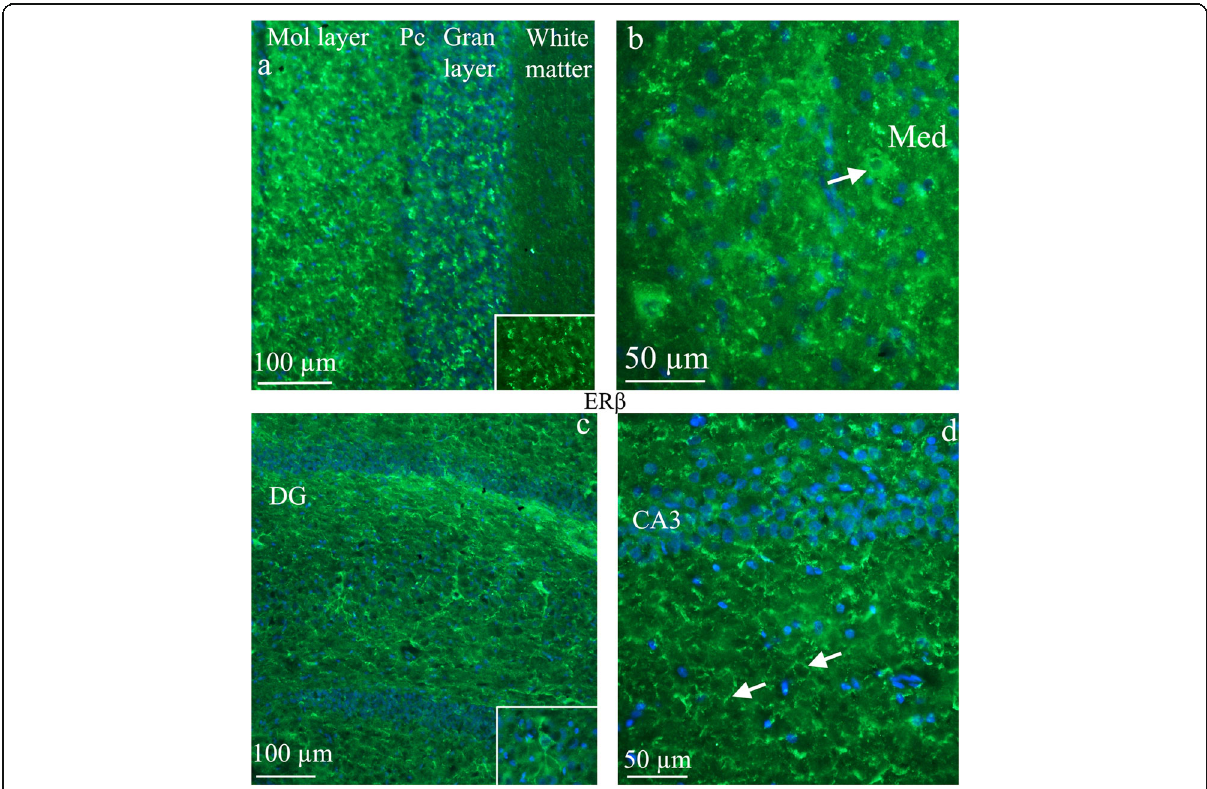
Fig. 3 ER β receptor distribution. a and b ) ER β receptor distribution in the cerebellum - the expression of ER β was often observed in tiny loop- formations or short curvatures in areas close to the cell surface or intercellularly, reminiscent of extra cellular matrix distribution. In the cerebellum, the typical ER β expression was found in the molecular (mol layer) and granular (gran layer) layers, but not in the Purkinje cells (Pc) and not in the white matter. Insert: staining of the granular layer. In Medial cerebellar nuclei (Med), occasional neuronal expression was observed (arrow). c and d ) ER β receptor distribution in the hippocampus - the dentate gyrus (DG) and CA3 are parts of hippocampus. Some ER β positive pyramidal cells were found in DG (insert). In the other parts of hippocampus, staining resembling cell surface or extracellular matrix immunoreactivity was observed